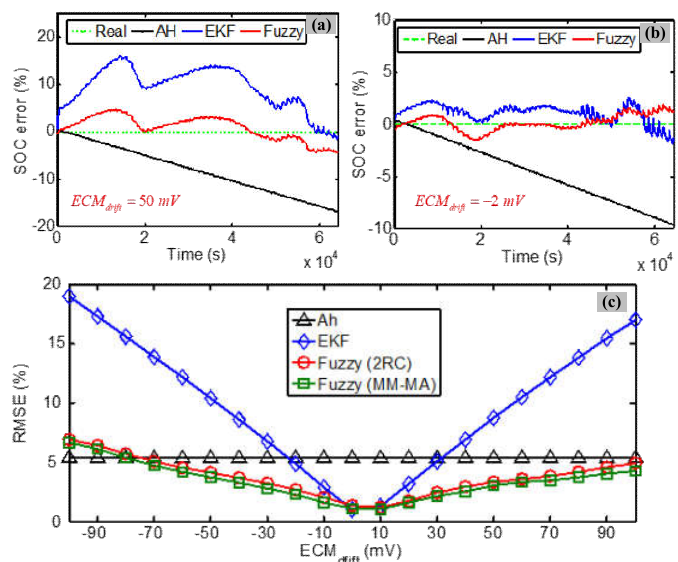
ECM  ; ( b ) 2 mV ECM   ; and ( c ) RMSE drift drift